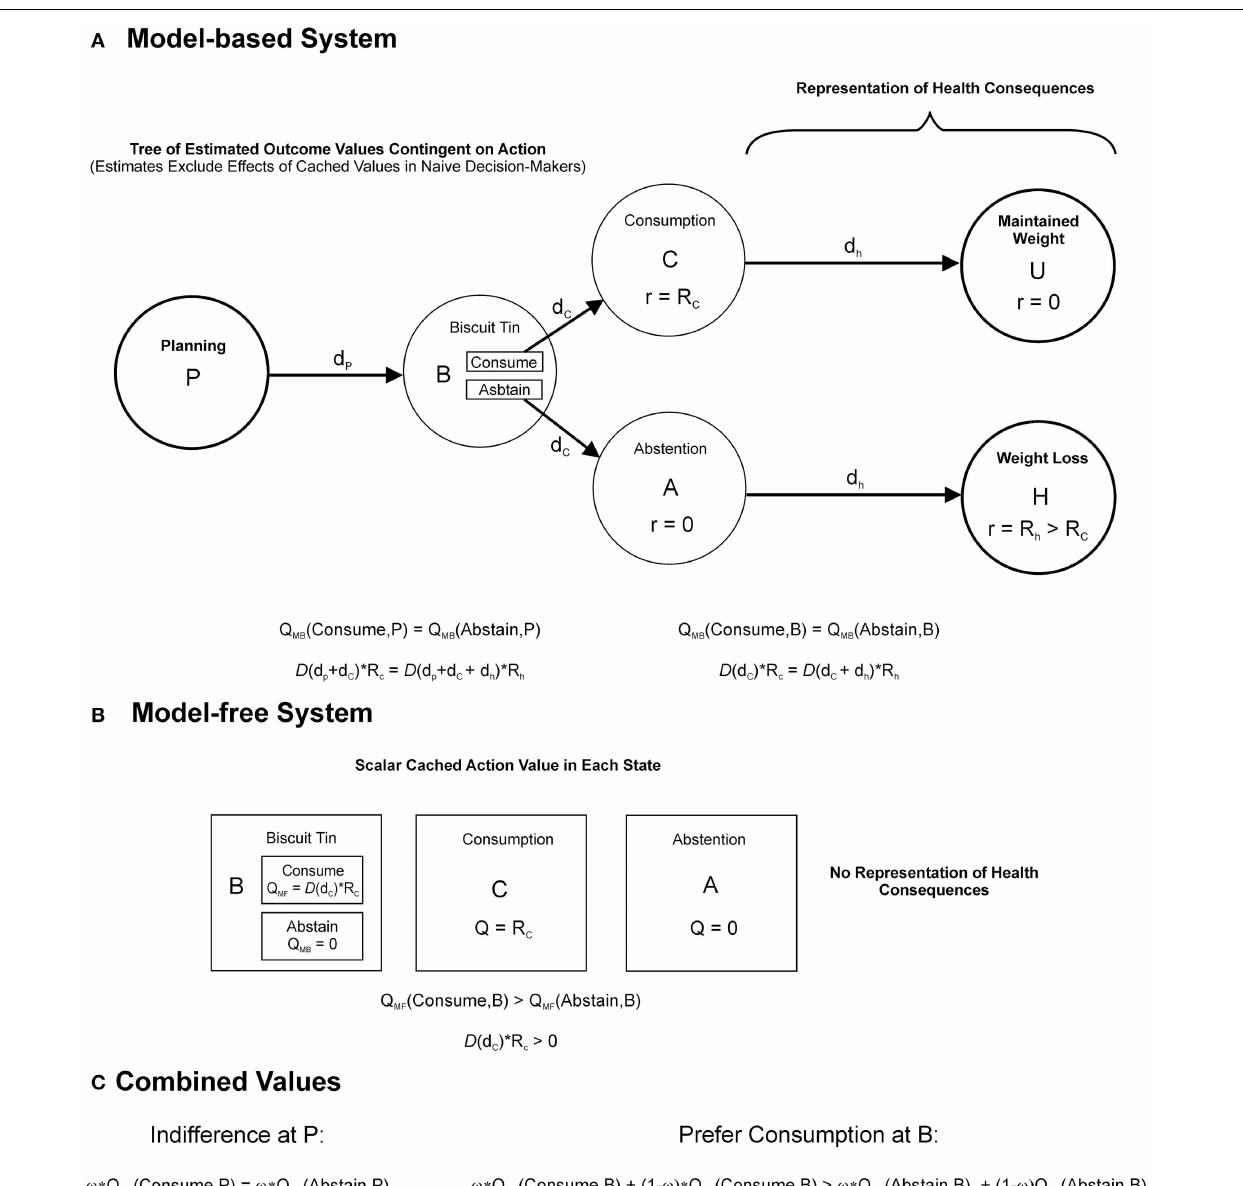
Model-based action values, Q MB , are given by the sum of future rewards following each action, discounted according to a function, D ( t ) , assumed to be exponential and identical across both controllers. The equations below indicate that the model-based system in this instance is indifferent between consuming and abstaining at both P (left hand equation) and B (right hand equation). (B) Cached values stored by the model-free system, which reflect the result of prior experience with the outcomes. Neither the outcomes themselves, nor the transitions between them, are explicitly represented. Similarly, because the distant health consequences have never been experienced, they do not influence the model-free Q -values, Q MF . As a result the model-free system prefers consumption at state B. (C) Model-based and model-free values are assumed to combine according to a weighted average, governed by the parameter, ω . At P , where model-free values have no influence, the agent is indifferent between consuming and abstaining. In the presence of the biscuit tin at B however the additional influence of model-free (cached) values induces a preference for